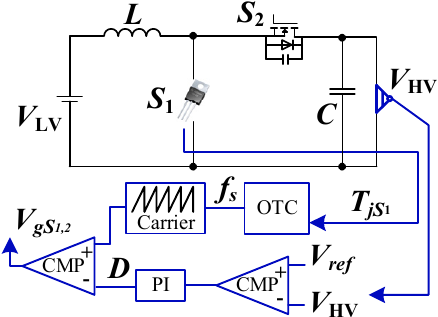
Figure 8. The proposed control block diagram.